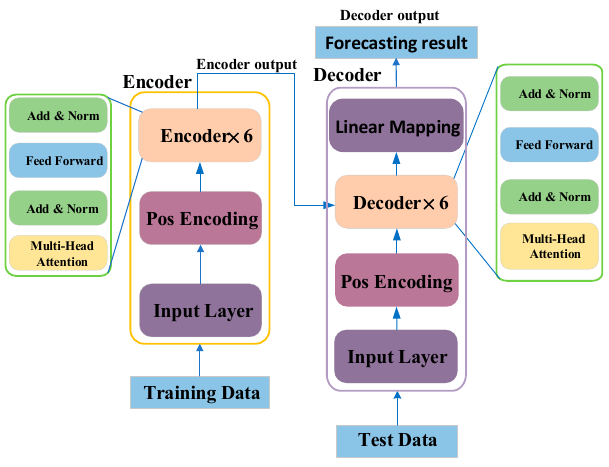
Figure 2. The structure of the Transformer Model.